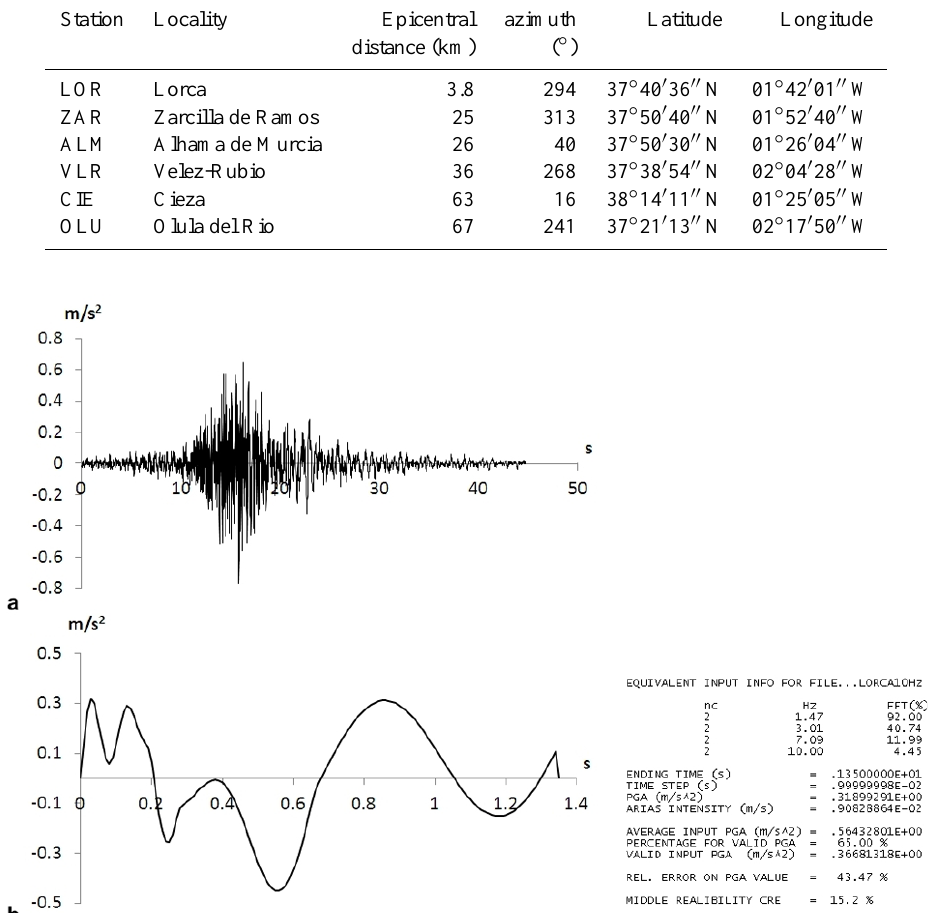
Fig. 5. (a) Accelerometric record for the seismic input derived for the rockslide site, 8km from the epicenter of the Lorca earthquake; (b) Accelerometric time series for the LEMA DES dynamic equivalent signal and related final report (Lenti and Martino, 2010) obtained for the seismic input referred to the rockslide site, 8km from the epicenter of the 11 May 2011 mainshock of the Lorca seismic